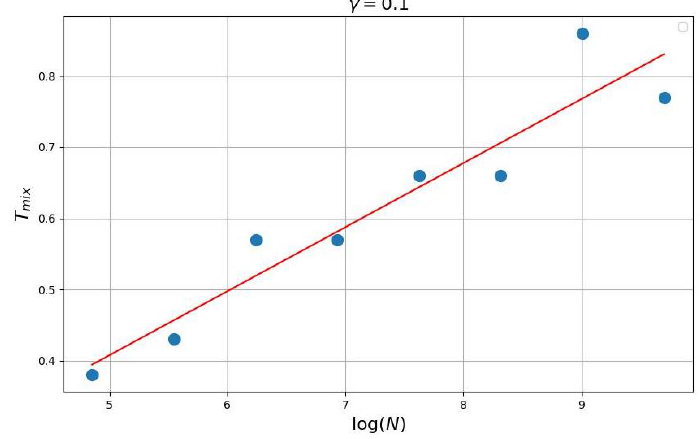
Figure 2. Logit-choice dynamic γ =